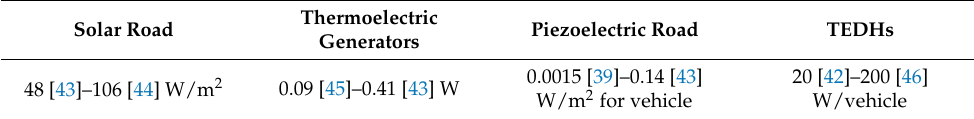
Table 2. Power generated by the different energy harvesting